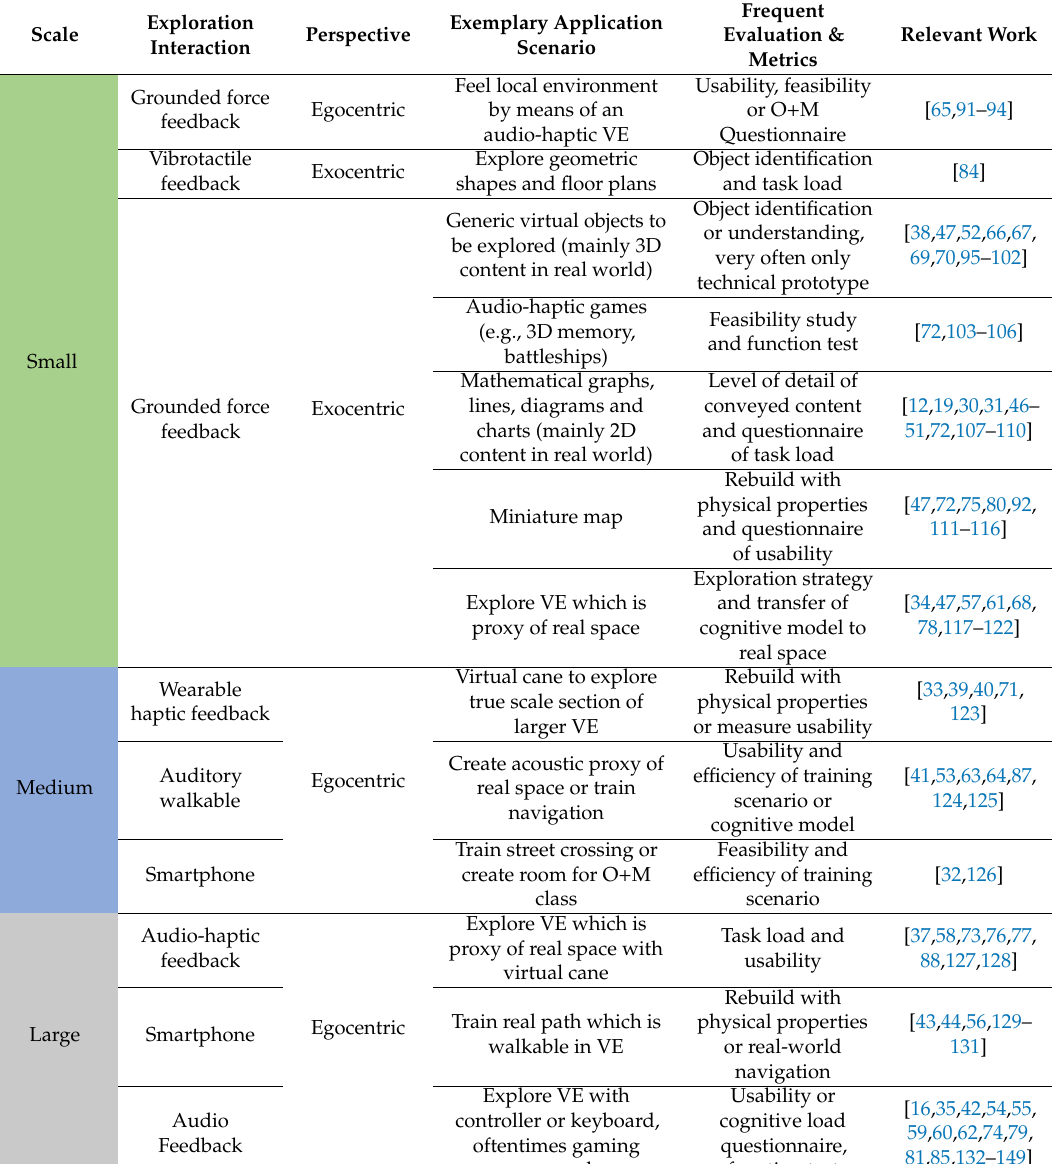
Table 2. Clustering of related work based on the proposed taxonomy. In addition, a frequent example of application and evaluation is given for each cluster. In the first column, small scale works are marked green, medium scale blue and large scale works